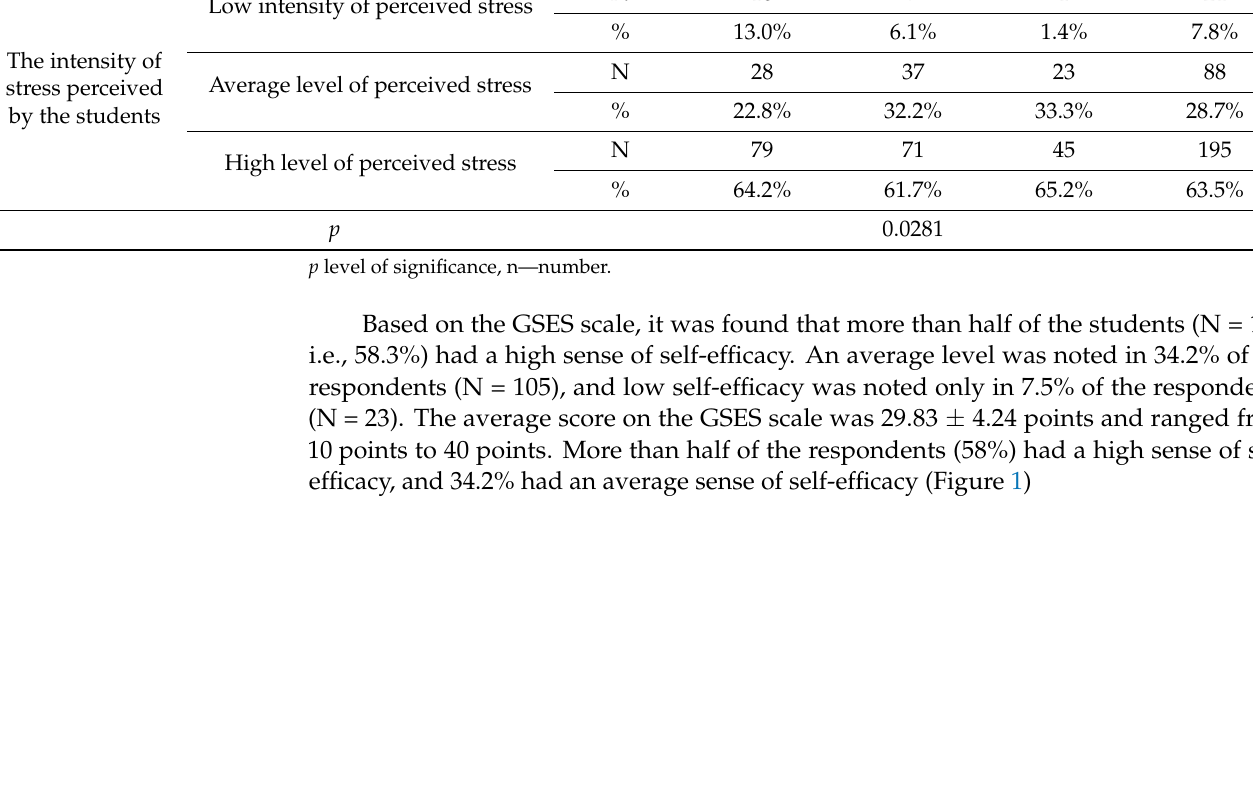
Table 1. The level of intensity of perceived stress depending on the year of study. Perceived Stress Scale